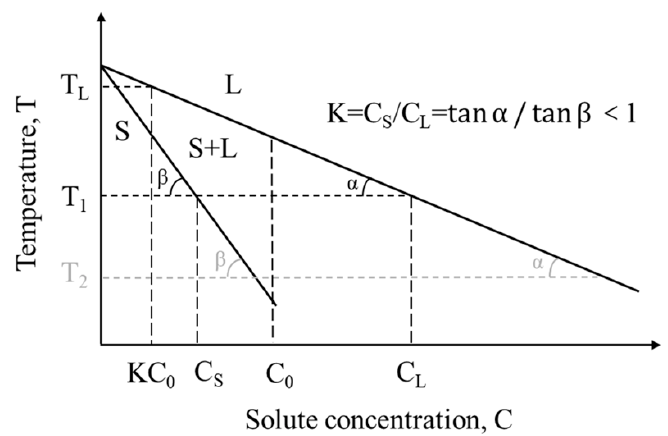
Figure 9. EPMA line scan of weld metal: ( a ) and ( c ) TIG; ( b ) and ( d ) SAW .